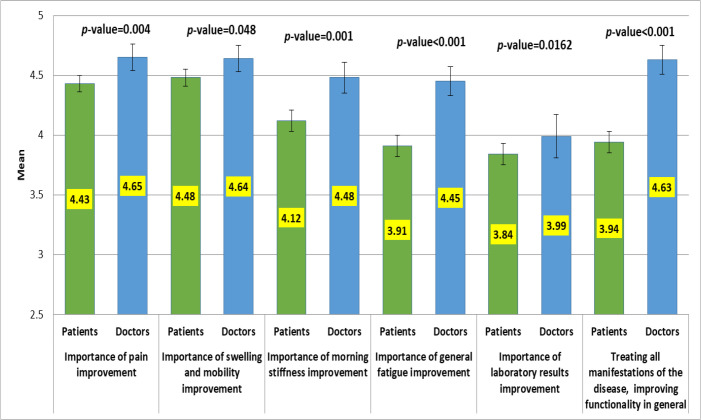
Importance of factors in determining the effectiveness of treatment.Note: p-values from t-tests of the mean difference between doctors and patients’ responses for each dimension.